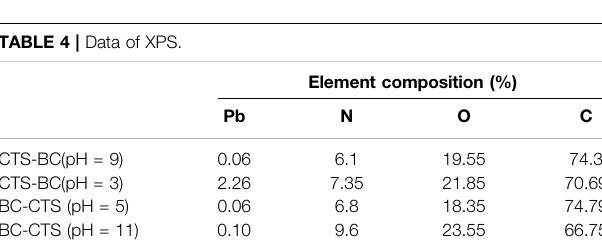
TABLE 4 | Data of